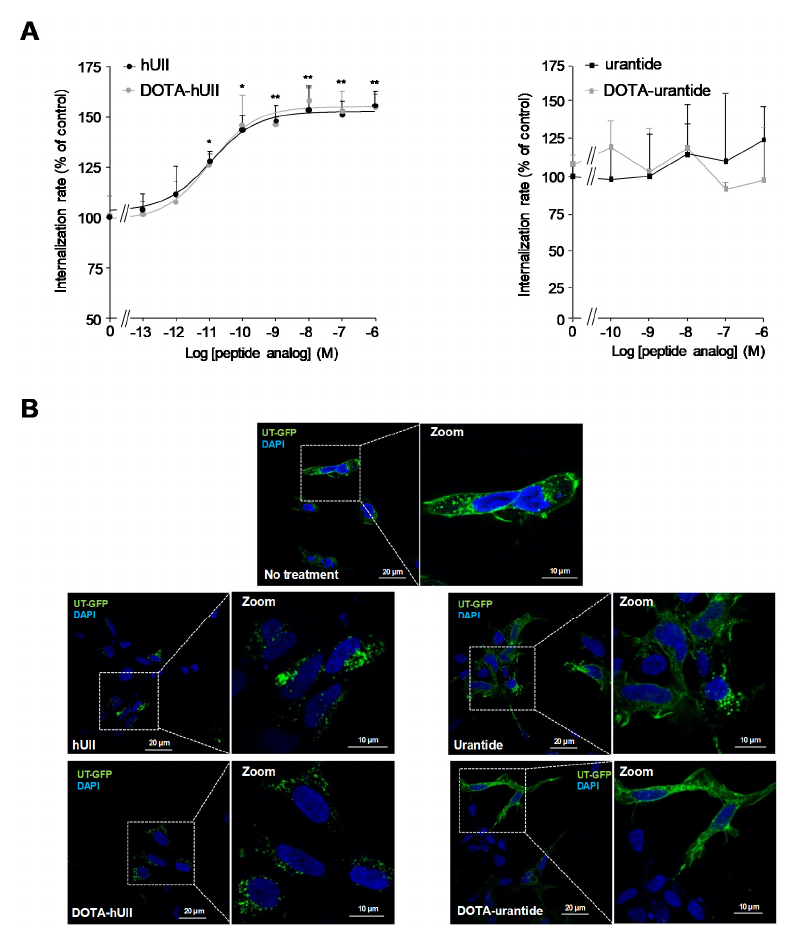
Figure 4. Effects of hUII, urantide and their DOTA analogues on UT internalisation. ( A ) Quantification of internalisation rate of UT in HEK-293 cells exposed for 1 h to graded concentrations of hUII or DOTA-hUII (left, 10 − 13 M to 10 − 6 M, each) and urantide or DOTA-urantide (right, 10 − 10 M to 10 − 6 M, each). Data are mean ± SEM of three to six independent experiments. ( B ) Representative confocal microscopy images of HEK-293 cells expressing UT-GFP (green) treated for 1 h with hUII or DOTA-hUII (left, 10 − 7 M, each) and urantide or DOTA-urantide (right, 10 − 7 M, each).